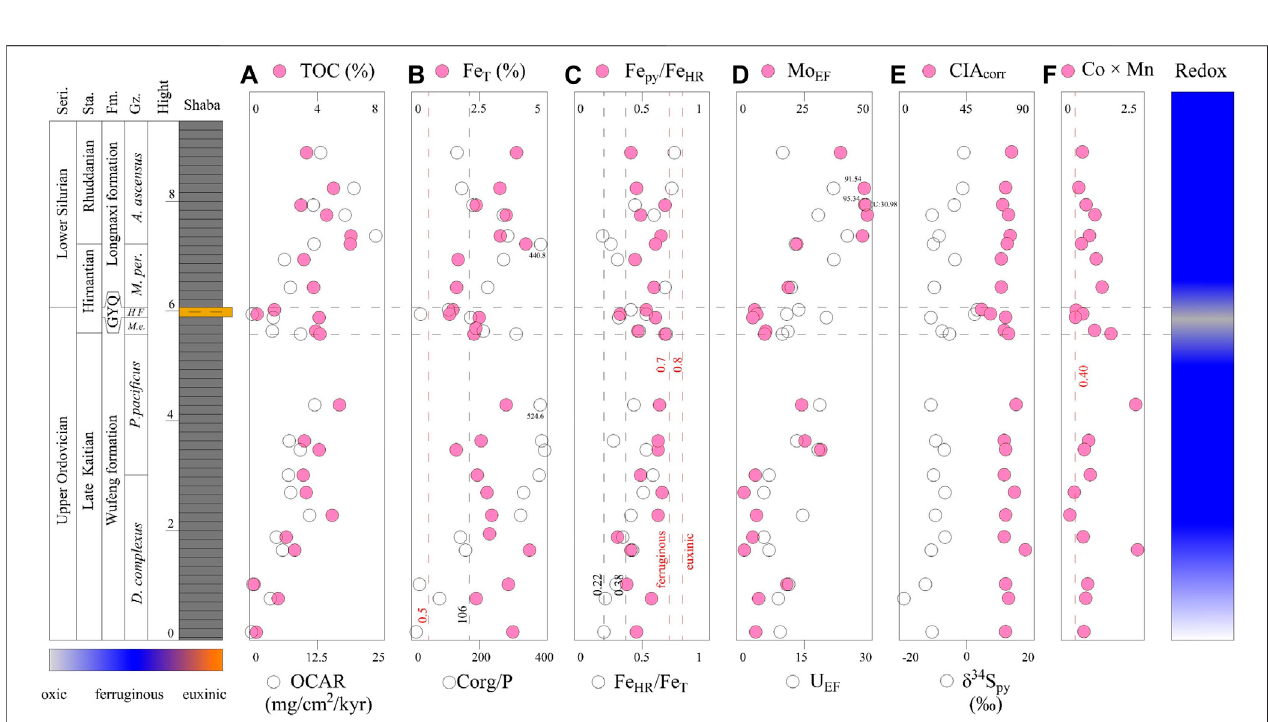
FIGURE 3 | Chemostratigraphic pro fi les of (A) total organic carbon (TOC) and organic carbon accumulation rate (OCAR), (B) FeT and Corg/P, (C) FeHR/FeT and Fepy/ FeHR, (D) MoEF and UEF, (E) CIAcorr and δ 34Spy and (F) Co × Mn for Shaba section. The meaning of the virtual lines and numbers in the graph is consistent with Figure 2 .